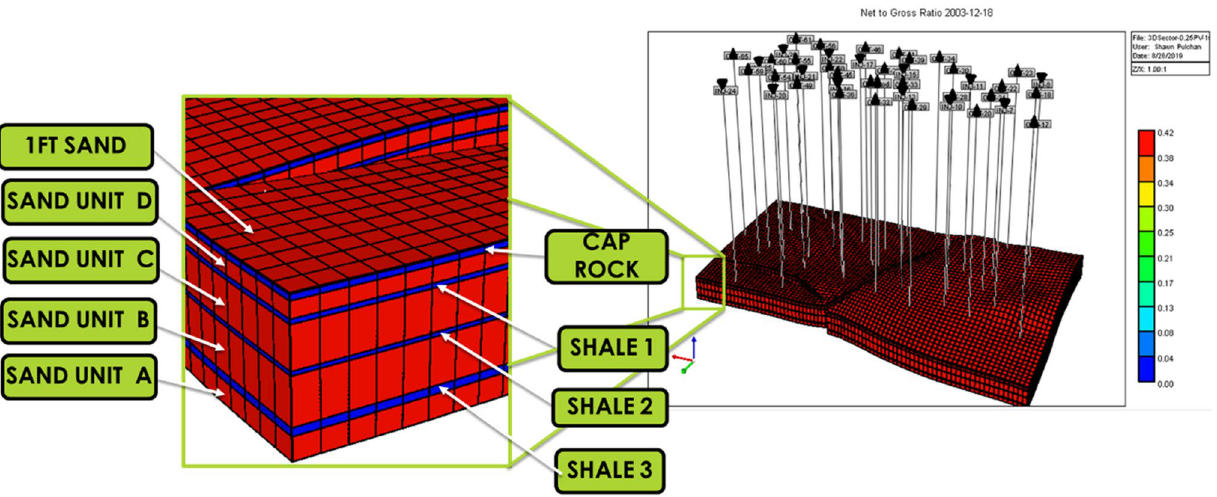
Fig. 7 Final three-dimensional GEM sector model for optimizing oil recovery and evaluating storage/leakage